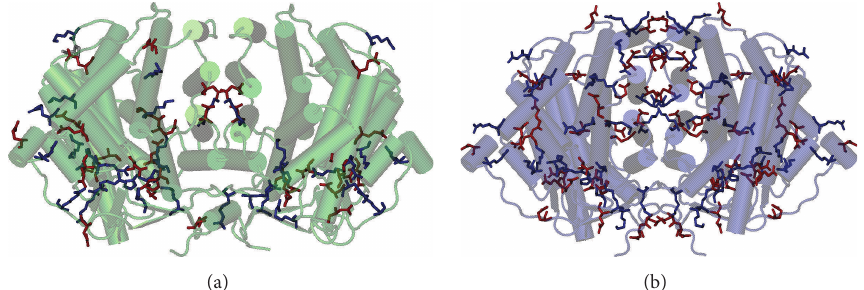
Figure 6: Charged residues forming ion pairs in the dimer of ST1805-CS (a) and ST0587-CS (b). Polypeptide chains are represented as a cylinder model. The positively and negatively charged residues are drawn as a line model and colored blue and red,